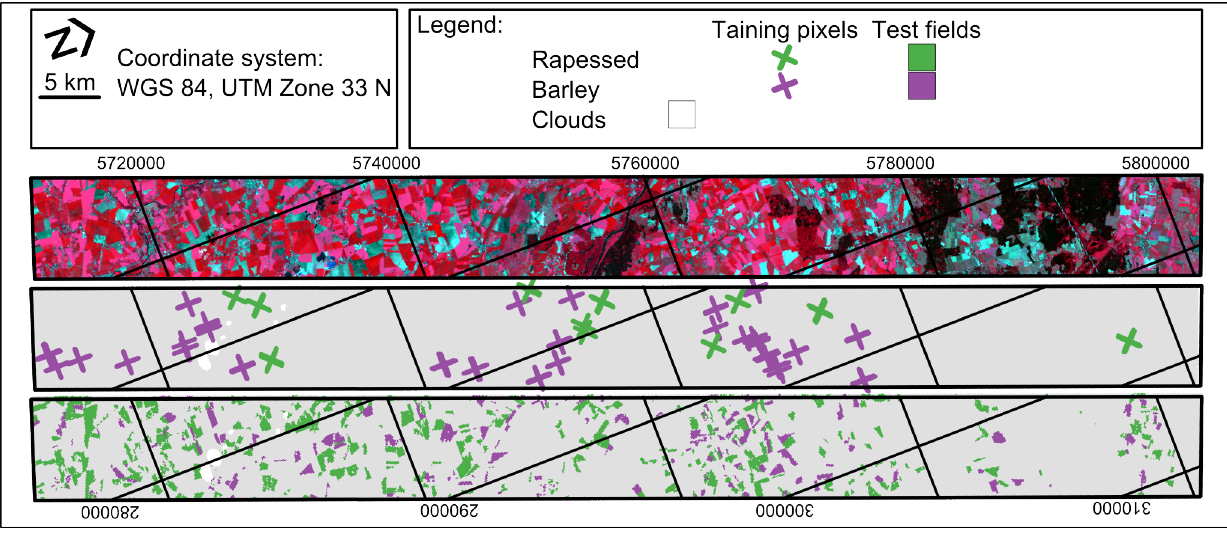
Figure 2. Image data and reference information used in the